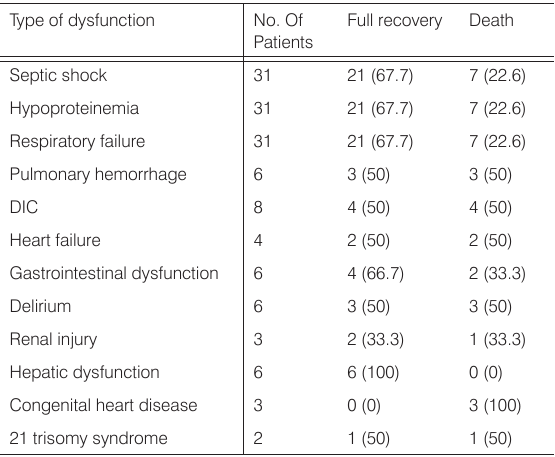
Table 1. Summary of clinical outcomes of 31 patients with capillary leak syndrome Type of